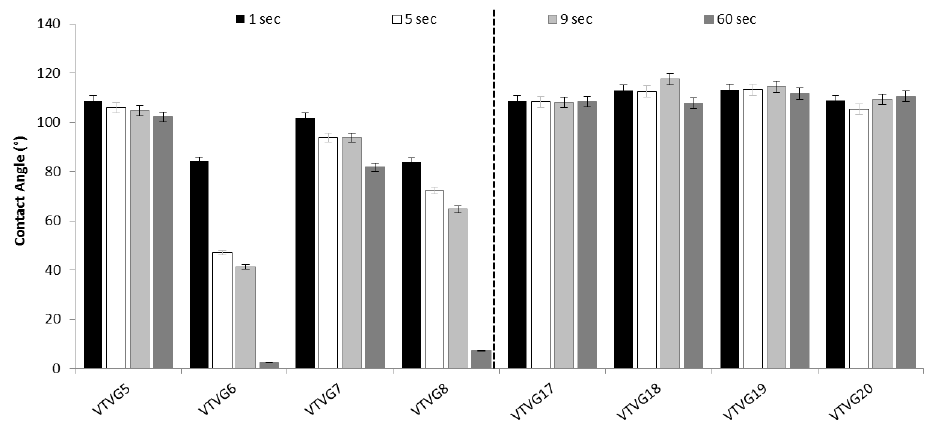
Figure 4. Contact angle and absorption kinetic of PLA-PCL and PLGA VTVGs. Data are expressed as average ± standard deviation ( n = 6).